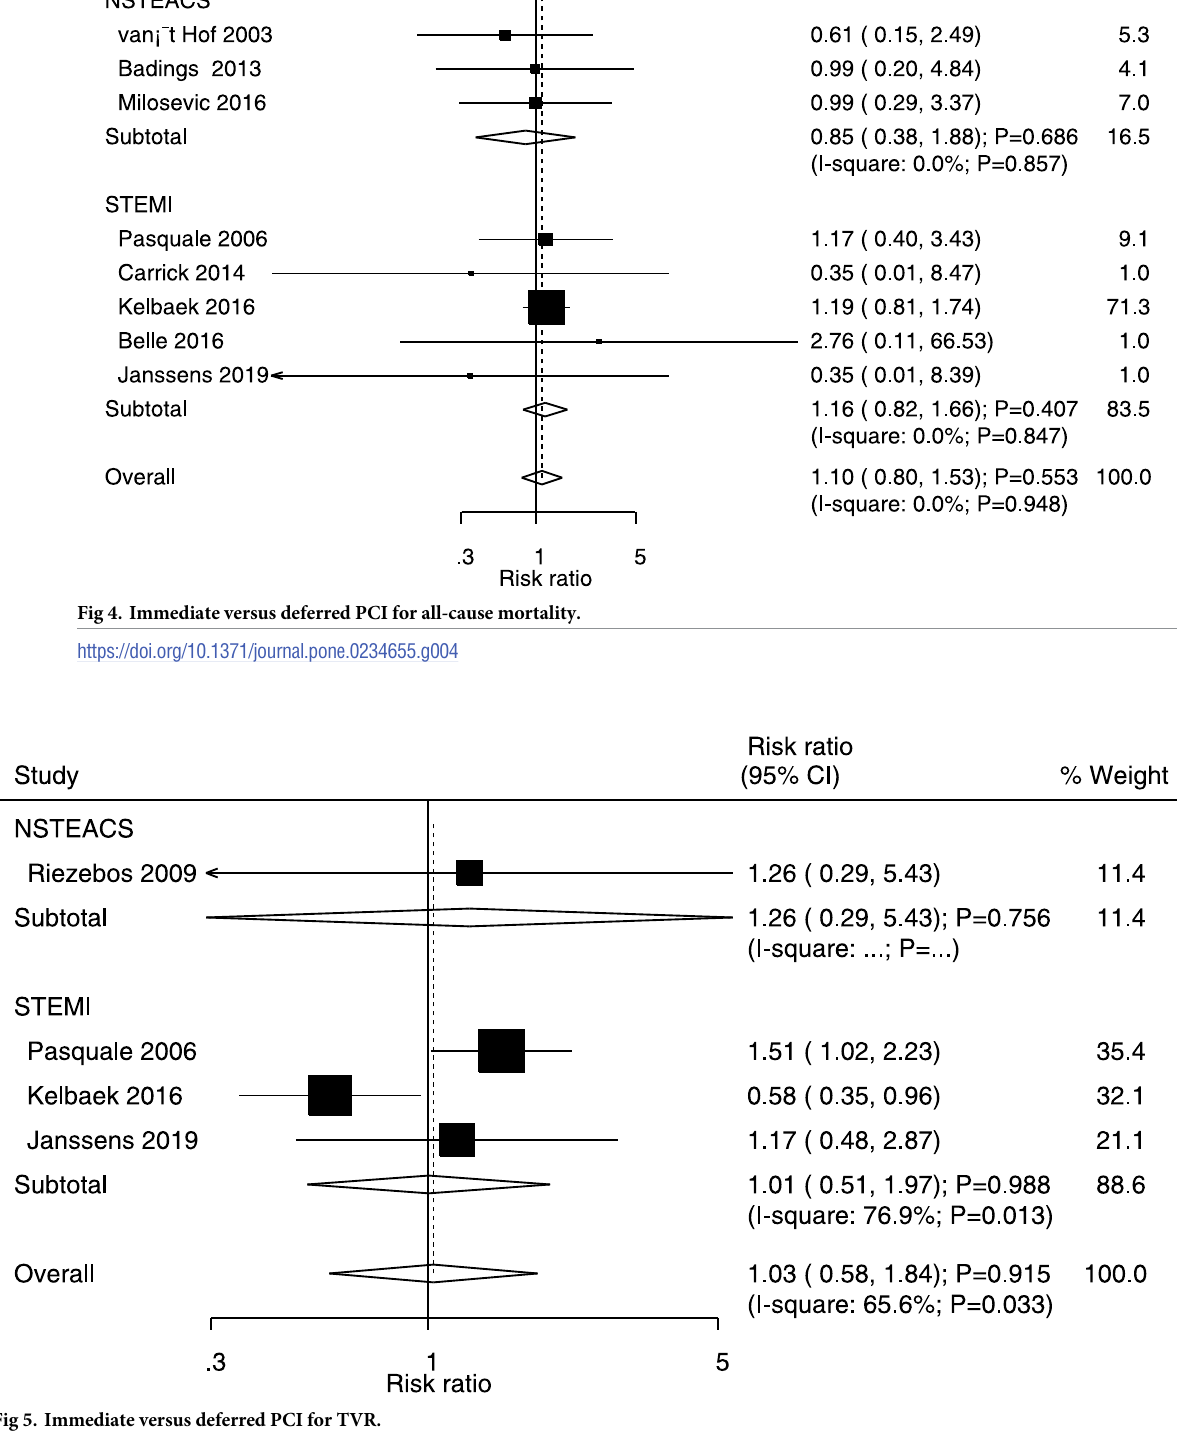
PLOS ONE | https://doi.org/10.1371/journal.pone.0234655 July 2,